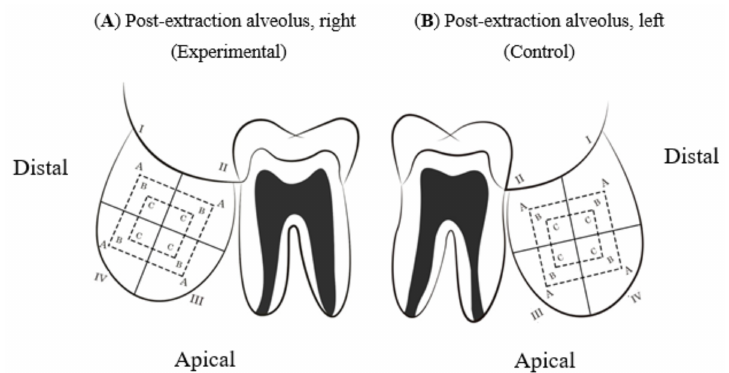
Figure 3. Bone regeneration diagrams for post-extraction alveoli. ( A ) EG, ( B ) CG.